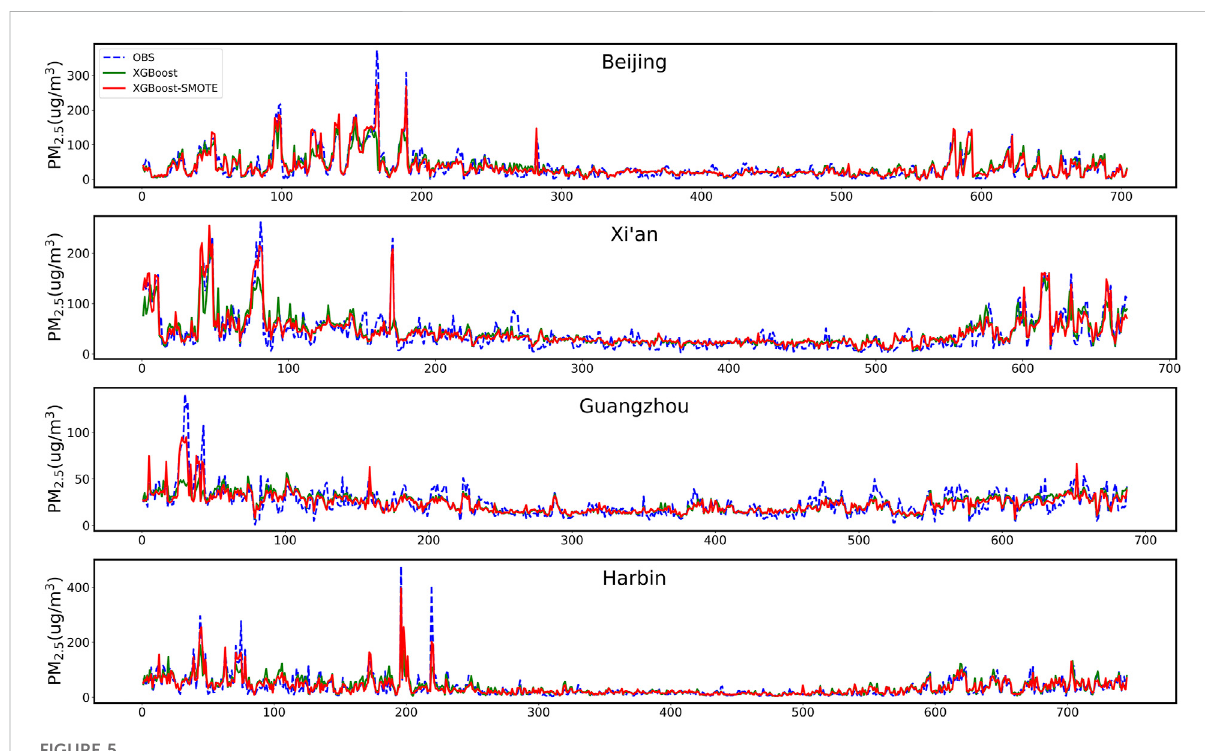
FIGURE 5 Results of PM 2.5 concentration for OBS (observation), XGBoost, and XGBoost-SMOTE